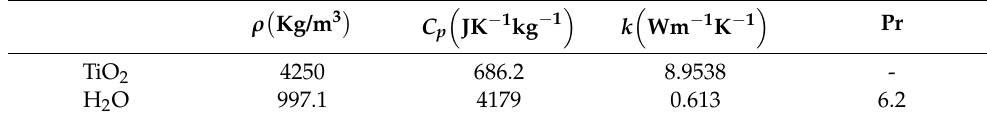
Table 4. Thermophysical properties of base liquid and nanoparticles.